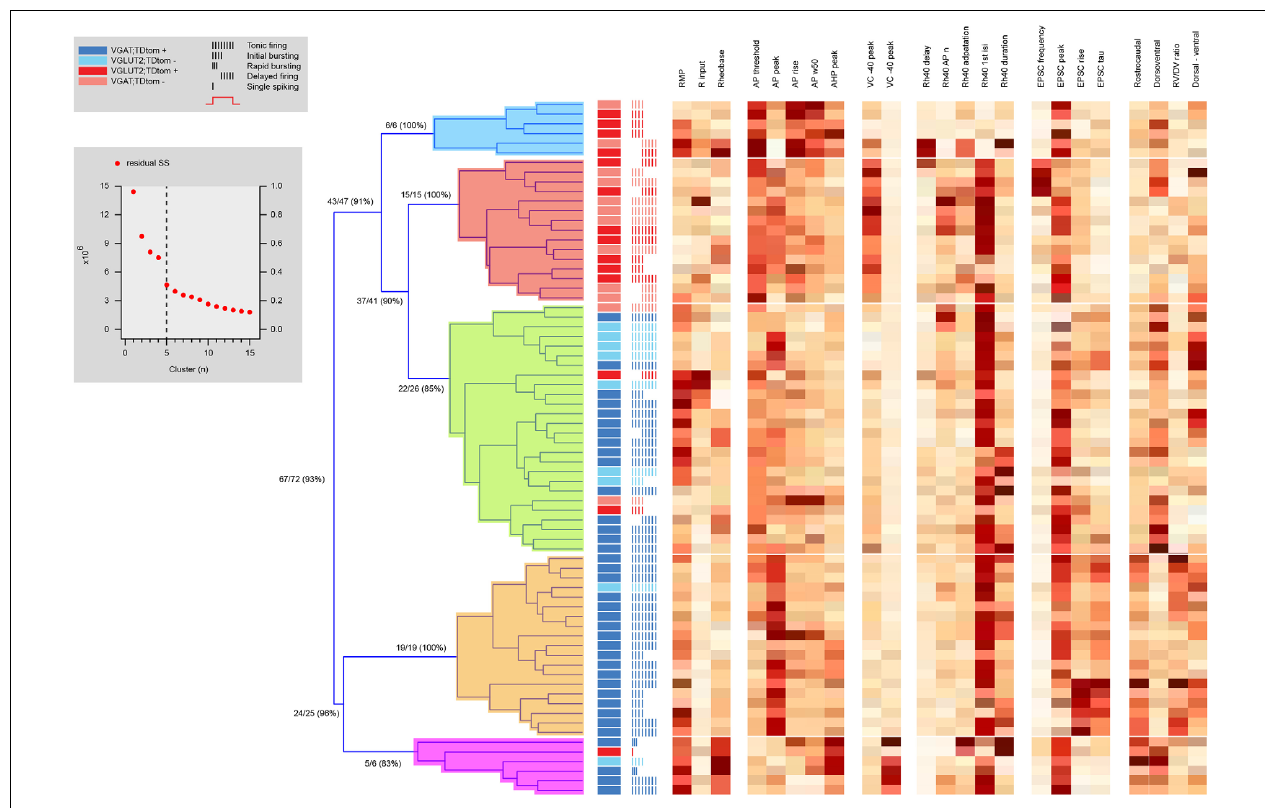
FIGURE 8 | Hierarchical cluster analysis of excitatory and inhibitory dorsal horn neurons on combined electrophysiological and morphological attributes. Dendrogram and heatmap plotting the assignment of dorsal horn neurons into clusters based on their electrophysiological and morphological properties. The distribution of excitatory and inhibitory neurons, as well as the AP discharge response pattern for each neuron, are annotated using the key summarized in the lower-left gray box, denoting neuron type and discharge pattern (inset). The number of clusters (four for this analysis) was assigned using a K-Means elbow method that plots the sum of squares error (SSE) for increasing cluster number to determine the point where additional clusters do not appreciably improve the SSE (upper gray box inset). Clustering using both electrophysiological and morphological attributes differentiates two purely excitatory clusters (blue and red), one purely inhibitory cluster (orange), and two clusters also dominated by inhibitory cells (green and pink). Heat maps highlight the relationship of 19 electrophysiological, and four morphological characteristics to each cell cluster assignment.